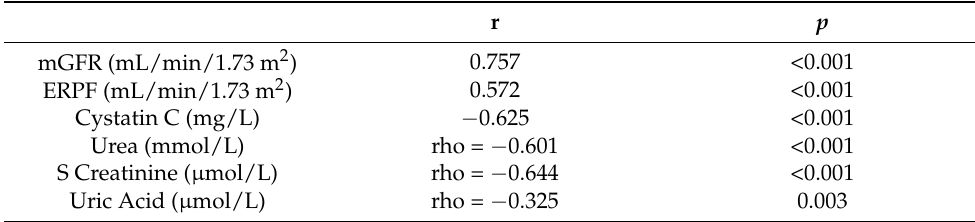
Table 3. Correlation between serum uromodulin and renal function